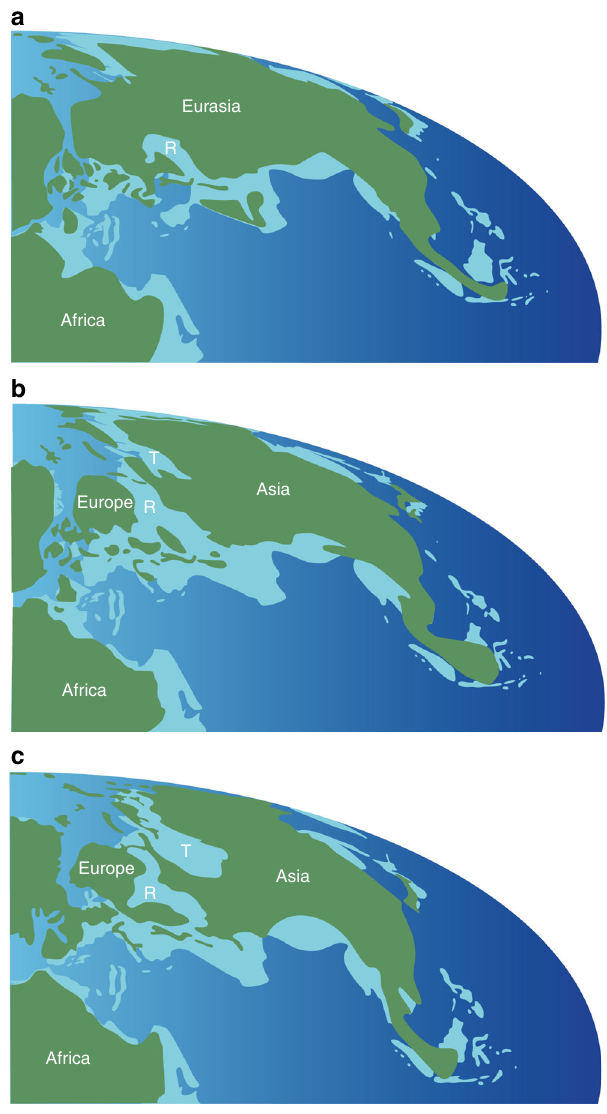
Fig. 4 Paleogeographic maps showing the formation and disappearance of an epicontinental seaway between Europe and Central Asia during the Middle Jurassic through Early Cretaceous. a Middle Jurassic (170 Ma); b Late Jurassic (160 Ma); c Early Cretaceous (138 Ma). The maps are based on ref. 48 . Green indicates land, light blue shallow sea, and deep blue ocean. Abbreviations: R, Russian Platform Sea; T, Turgai